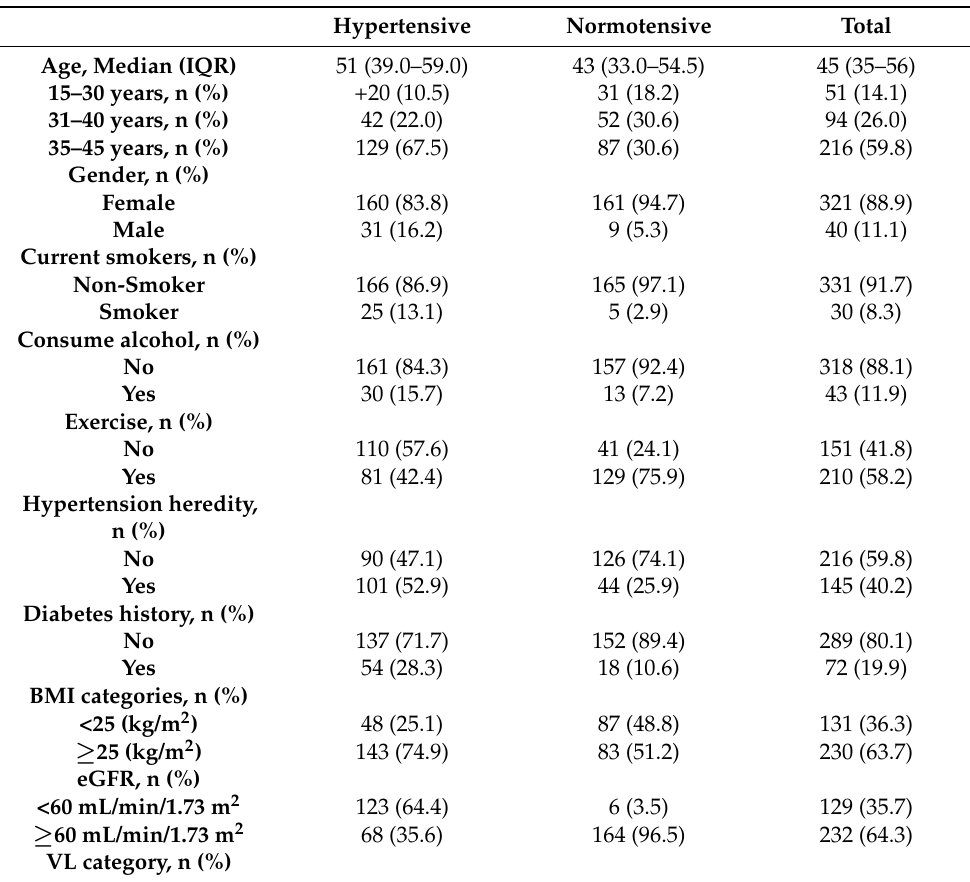
Figure 1. Patient flow chart of the study profile. Table 1. Summary of patient